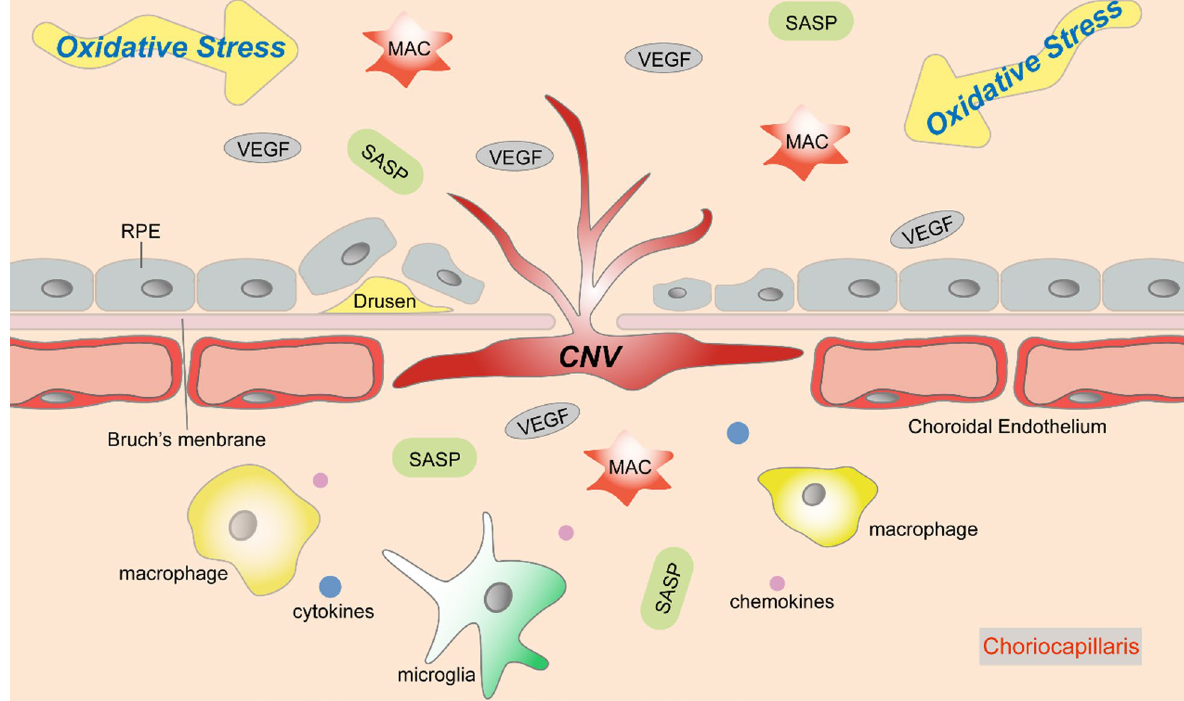
Fig. 2 The role of oxidative stress in Choroid-retinal pigment epithelium (RPE) damage during the progression of age-related macular degeneration (AMD). Oxidative stress induces ischemia and chronic inflammation in Choroid-RPE complex. Excess production of VEGF in response to ischemia initiates pathological angiogenesis, and then choroidal neovascularization (CNV) develops as a consequence. In addition, oxidative stress contributes to overactivation of inflammatory responses, consisted of the accumulation of membrane attack complex (MAC) and senescence-associated secretory phenotype (SASP), as well as the recruitment of activated macrophages and